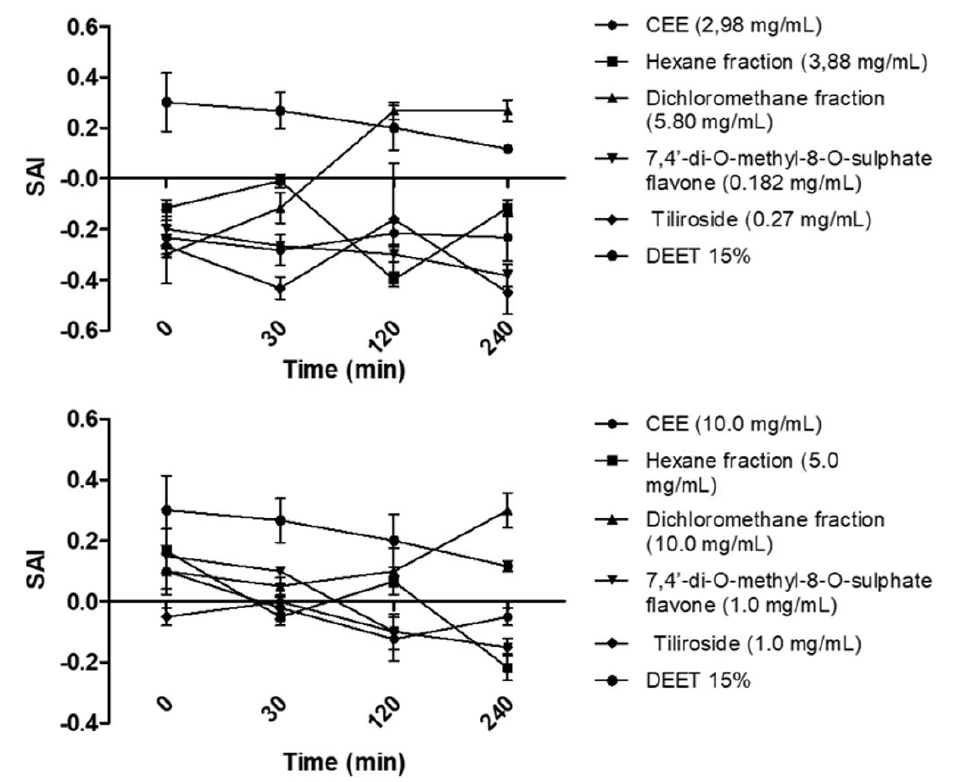
Figure 9. Spatial Activity Index (SAI) of the CEE, fractions and substances isolated from Helicteres velutina on females of Aedes aegypti